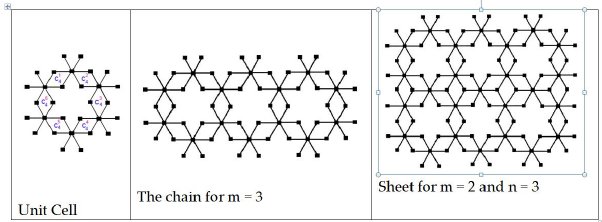
Figure 1. bismuth